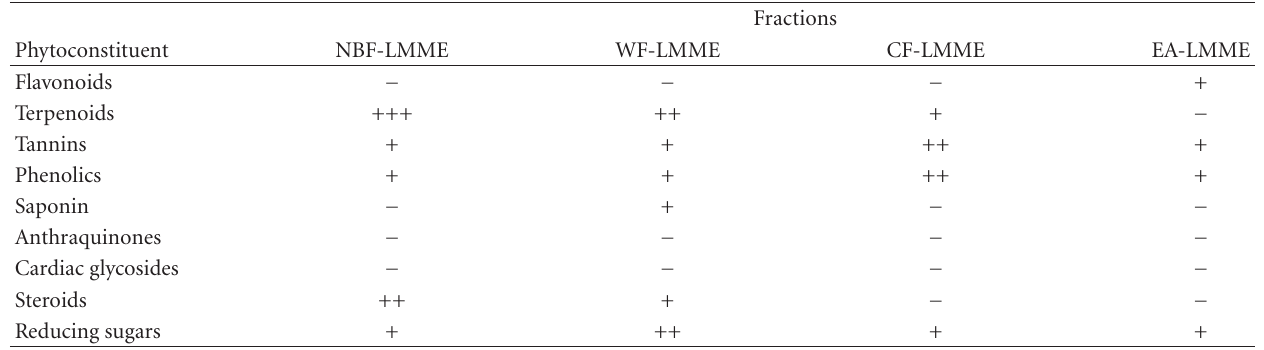
Table 3: Phytochemical screening of fractions recovered from Loranthus micranthus methanolic leaf extract.